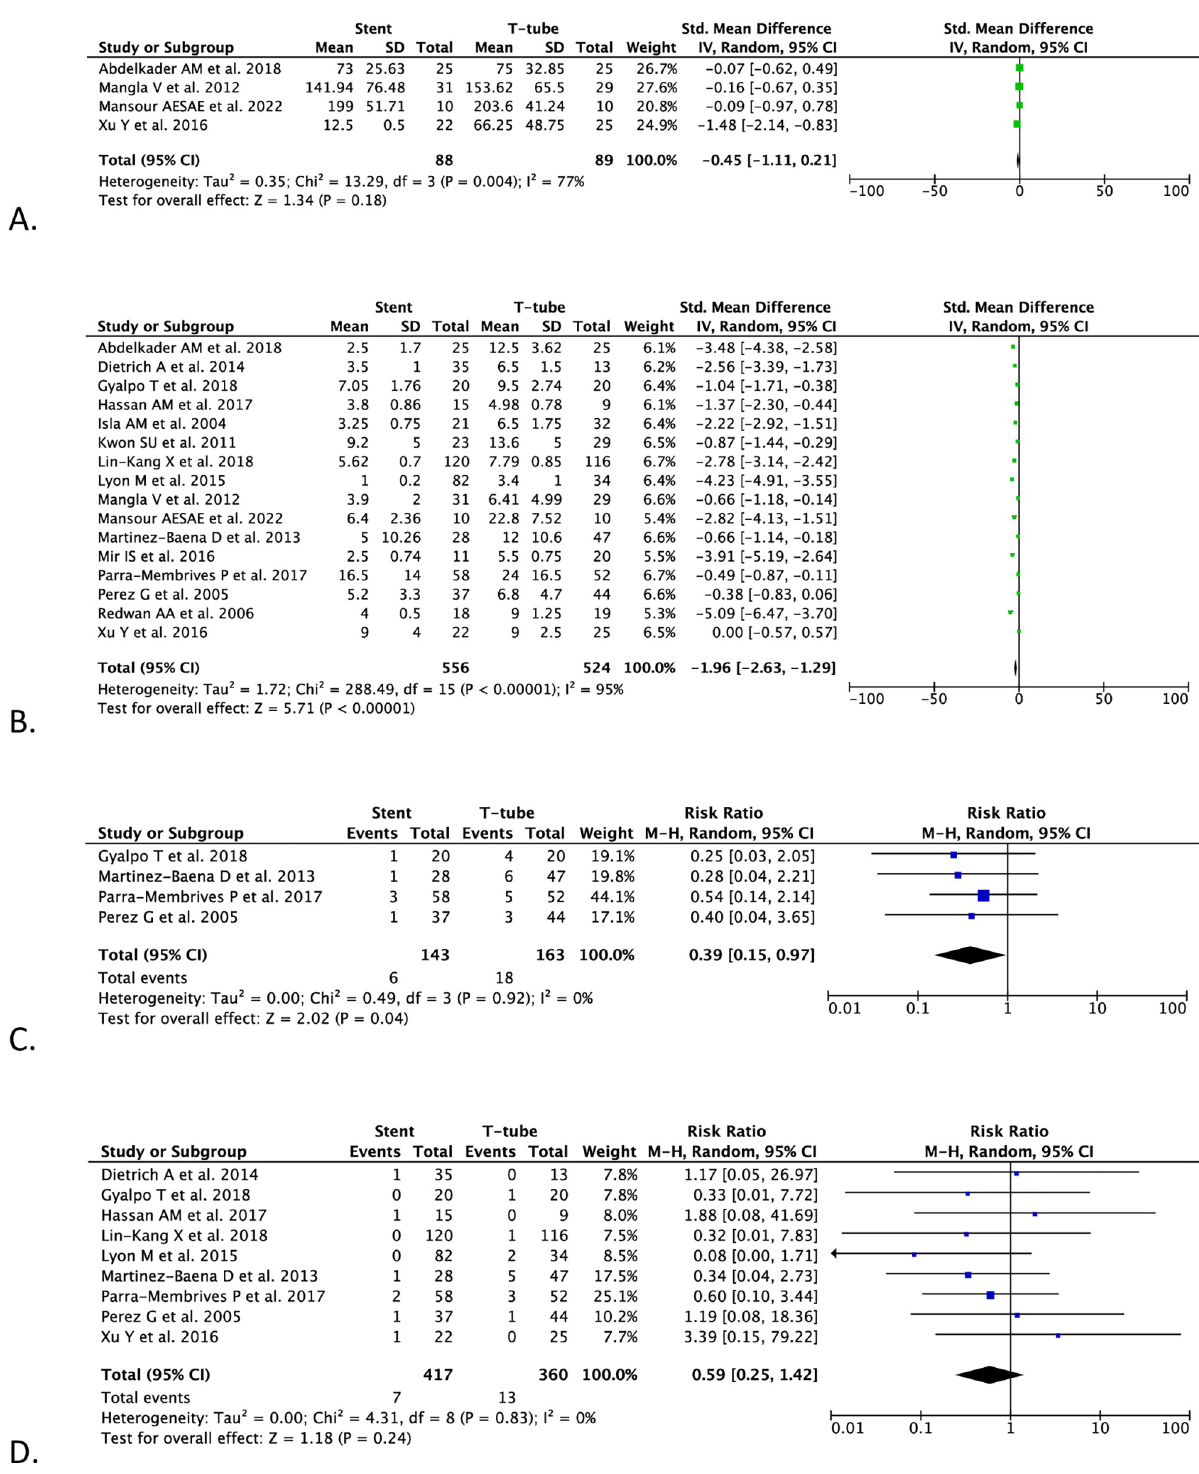
Fig 3. Forest plots of (A) blood loss volume, (B) length of hospital stay, (C) readmission rate, and (D) reoperation rate.